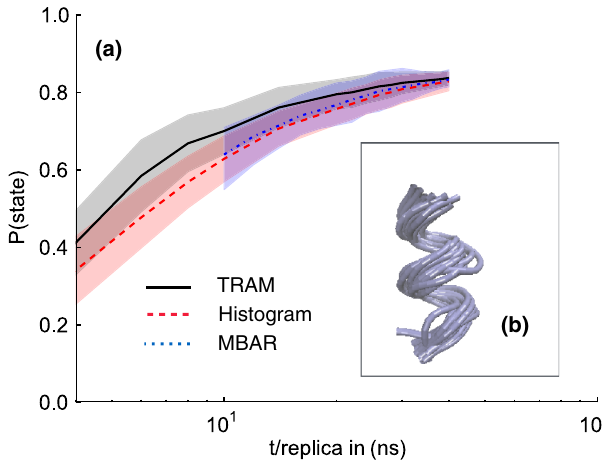
FIG. 5. (a) Convergence of the probability of the system being in a helical state with respect to the total simulation time per replica. The xTRAM estimate is given by the continuous black line, the histogram count by the dashed red line, and the MBAR estimate by the dashed-dotted blue line. Confidence intervals are obtained from ten independent REMD simulations. (b) Structure averages of the helix state whose convergence is shown in